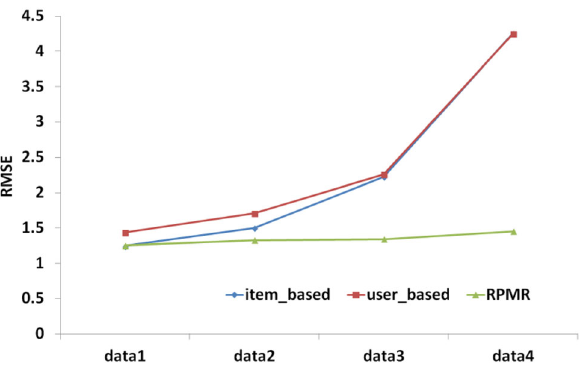
Fig. 16 RMSEs of compared methods on different data